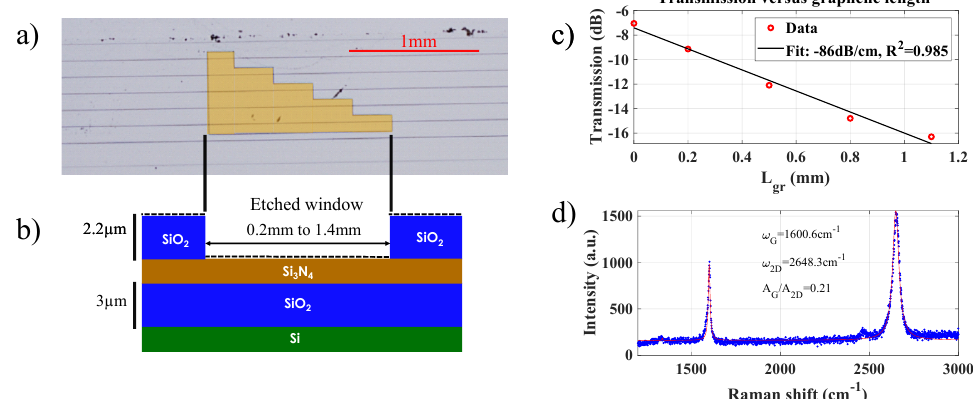
Figure 1. ( a ) Top-view optical microscope image of the waveguides with the window highlighted in orange, where graphene covers the waveguides. ( b ) Schematic view of the structure cross-section, around the etched cladding window. ( c ) Total transmission of the waveguides as a function of the graphene length covering the Si 3 N 4 waveguide (i.e., the length of the associated cladding window). ( d ) Raman spectrum measured (blue dots) and fitted (red line) of the graphene in direct contact with the waveguide. The A G / A 2 D is the ratio of the peak area obtained from the fit, and allows one to check that the graphene is monolayer